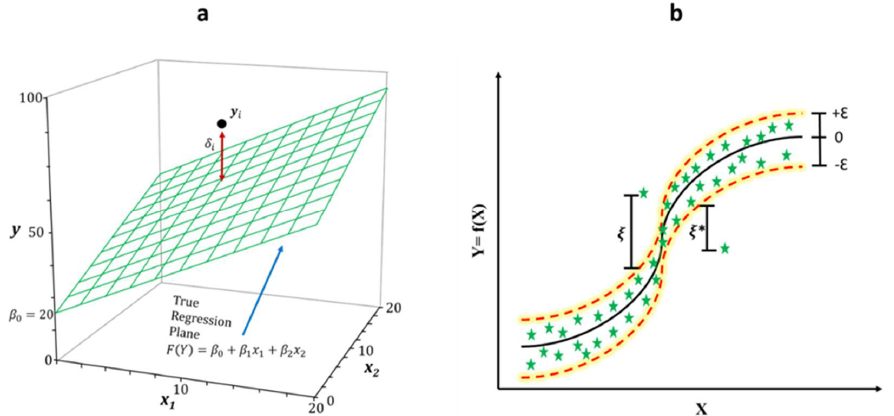
Figure 3. Diagrams show the structure of ( a ) multiple linear regression (MLR) and ( b ) support vector machine regression (SVM-R)